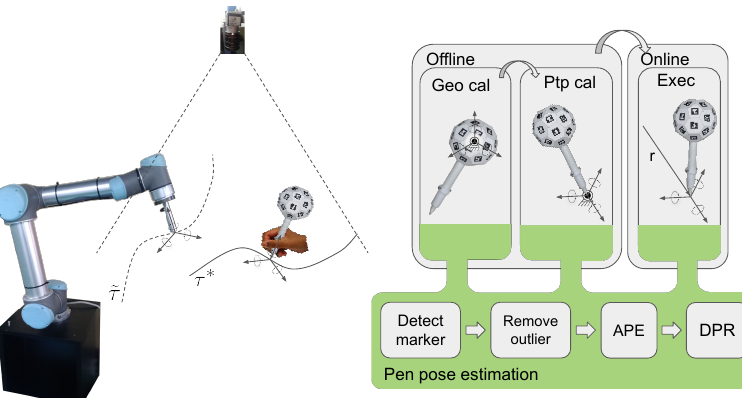
Figure 1. System overview depicting the system components and workflow. The workflow starts with an offline stage for pen calibration, including geometry (Geo cal) and pentip (Ptp cal), and an online execution stage (Exec) for deployment. The main pen pose estimation module takes part in each functioning stage.